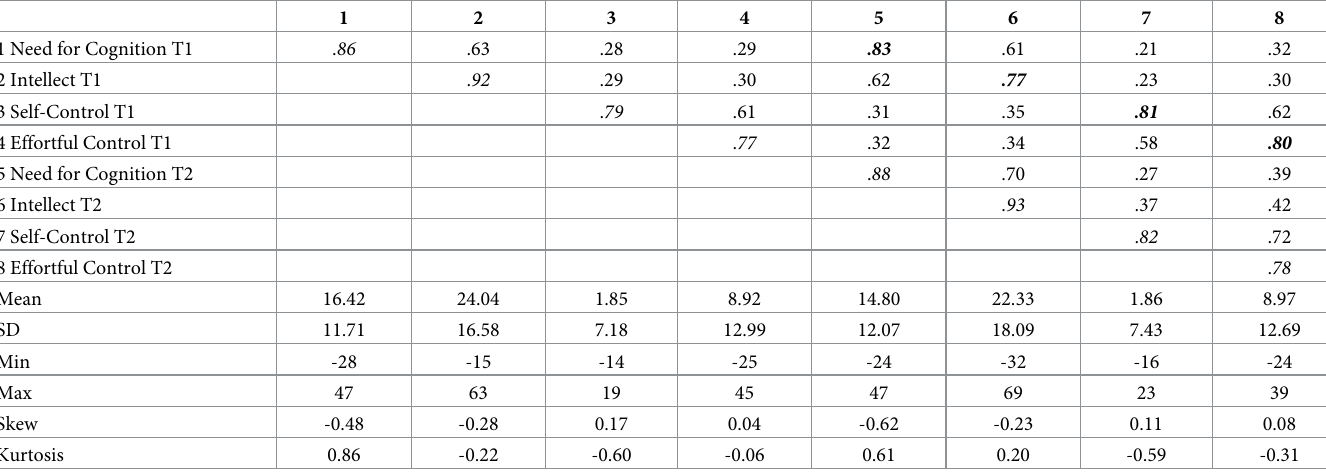
Table 1. Spearman correlations and descriptive statistics of the personality